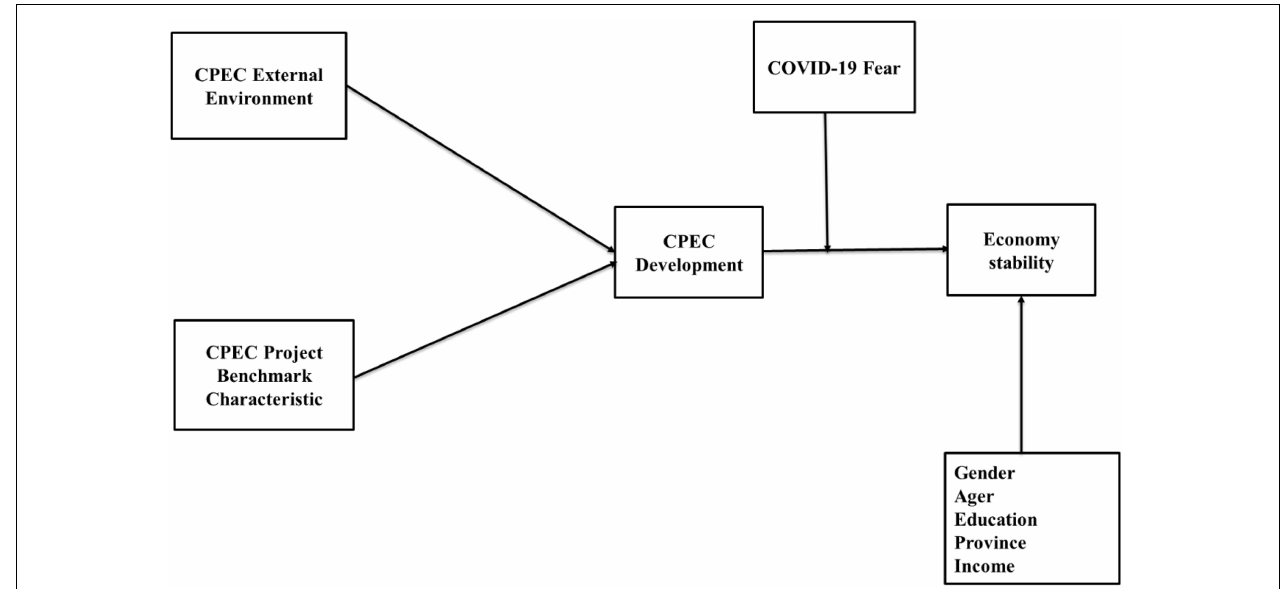
FIGURE 1 | Conceptual